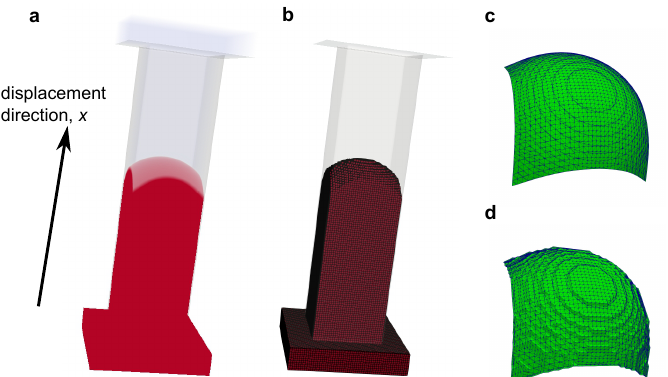
Figure 7. An example of the simulation results for a contact angle of θ = 45 ◦ . ( a ) The simulated phase distribution. Oil is shown in red, while water and solid phase are transparent; ( b ) The synthetic voxelized data from the simulated phase distribution. Here, only oil is shown; ( c ) The simulated interface extracted from the simulated phase distribution corresponding to the color function of ρ N = 0 (see Equation (12)) ( d ) The staircase interface extracted from the synthetic voxelized data.